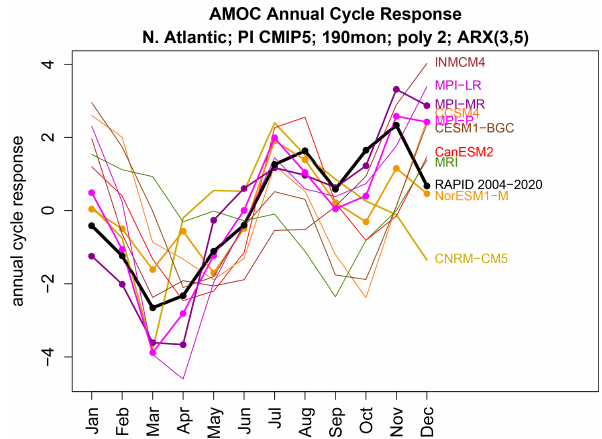
Figure 13. The annual cycle response of each ARX(3,5) model estimated from 190-month time series from CMIP5 models (col- ored curves) and from observations (black curve). Dots indicate an- nual cycles that differ significantly from that of observations at the FWER of 5%. Note that the dots have the opposite meaning than they do in Fig.